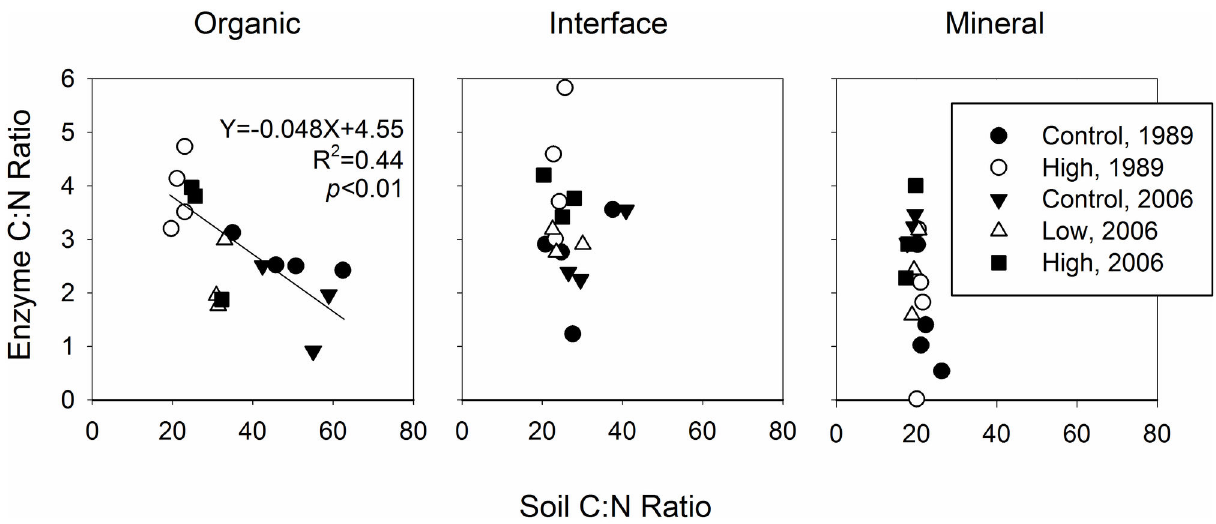
Figure 4. Relationship between soil C:N ratio and corresponding ratio of potential enzyme activities. Enzyme C and N are (BG+CB+XYL+AG) and (NAG+LAP), respectively, assayed at 15 °C. doi: